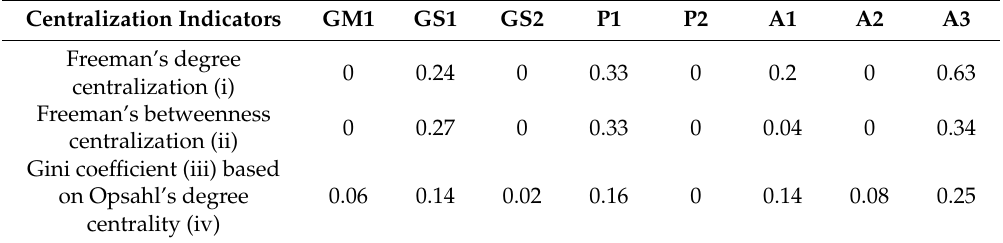
Table 3. Low ego-network centralization, indicating balance of power in the observed ego-centric networks. Centralization